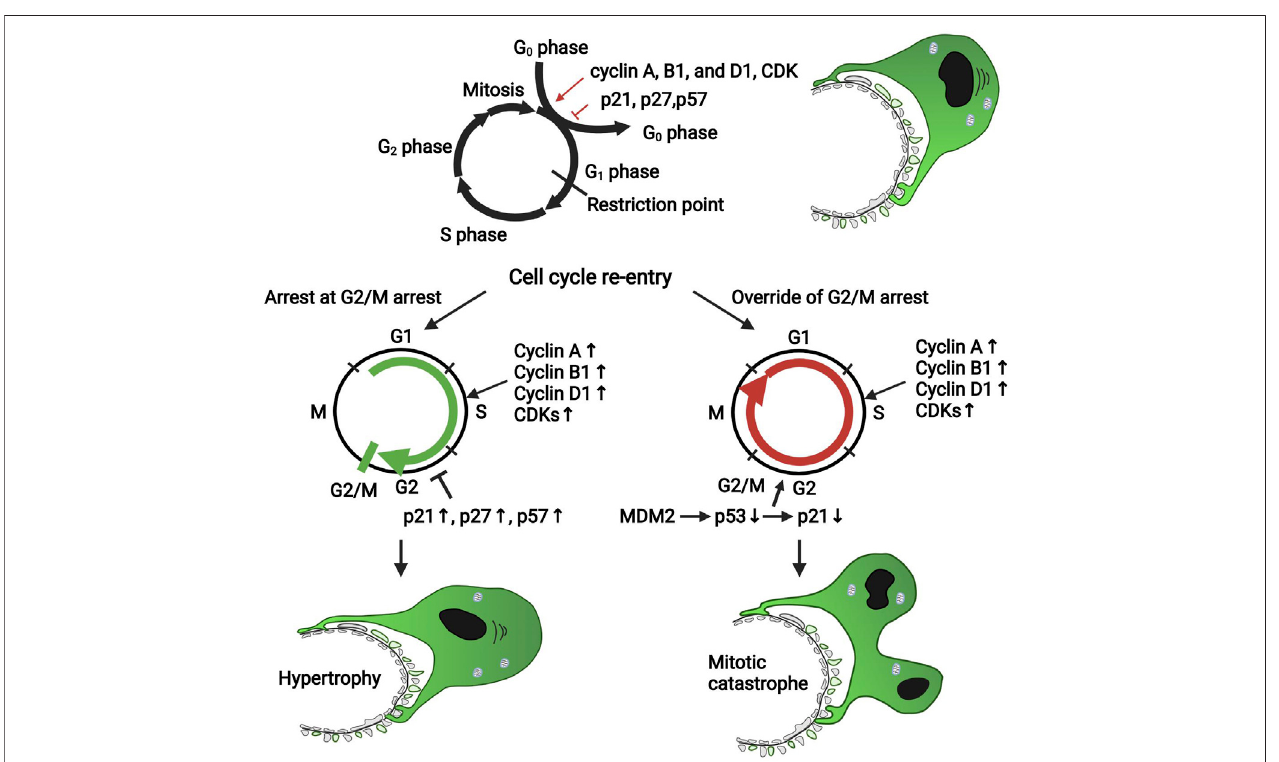
FIGURE2| Thecellcycleofthepodocyteindiseasedcondition.CellcycleproteinssuchascyclinA,cyclinB1,cyclinD1,andCDKspromotepodocytere-entryinto the cellcycle;however, theCDK inhibitorssuch asp21, p27, and p57 block thecell cycle.Mature podocytes express negligible cyclinA, cyclinB1, cyclinD1, and CDKs but constitutively express p27, p57, and WT-1, which maintain the cell cycle quiescence. During podocyte injury, many pathogenic factors such as FGF and TGF- β upregulatedtheexpressionofcellcycleproteinsfavoringtheproliferationtopromotethepodocytetooverridetheG1restrictionpoint;also,theCDKinhibitorswere upregulated to keep the cells arrest in the G2/M phase. Under some conditions, podocytes could override the G2/M restriction by MDM2 through inhibiting p53- dependent cell cycle arrest. However, due to the incomplete formation of mitosis and cytokinesis, podocytes could not complete successful division; thus, a mitotic catastrophe of podocytes occurs. CDK, cyclin-dependent kinase; MDM2, murine double minute 2.